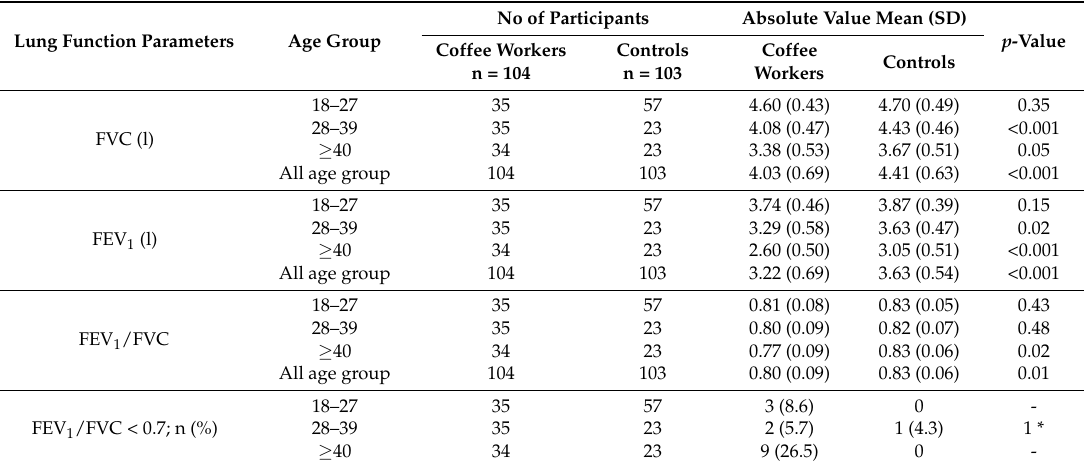
Table 3. Lung function among primary coffee processing factories and control groups stratified by age (three age